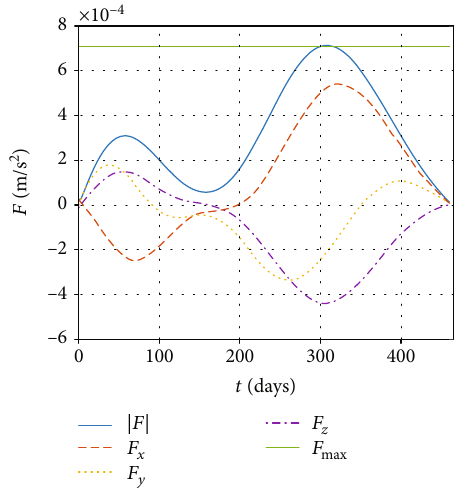
Figure 12: Optimal Tempel-1 rendezvous trajectory acceleration.